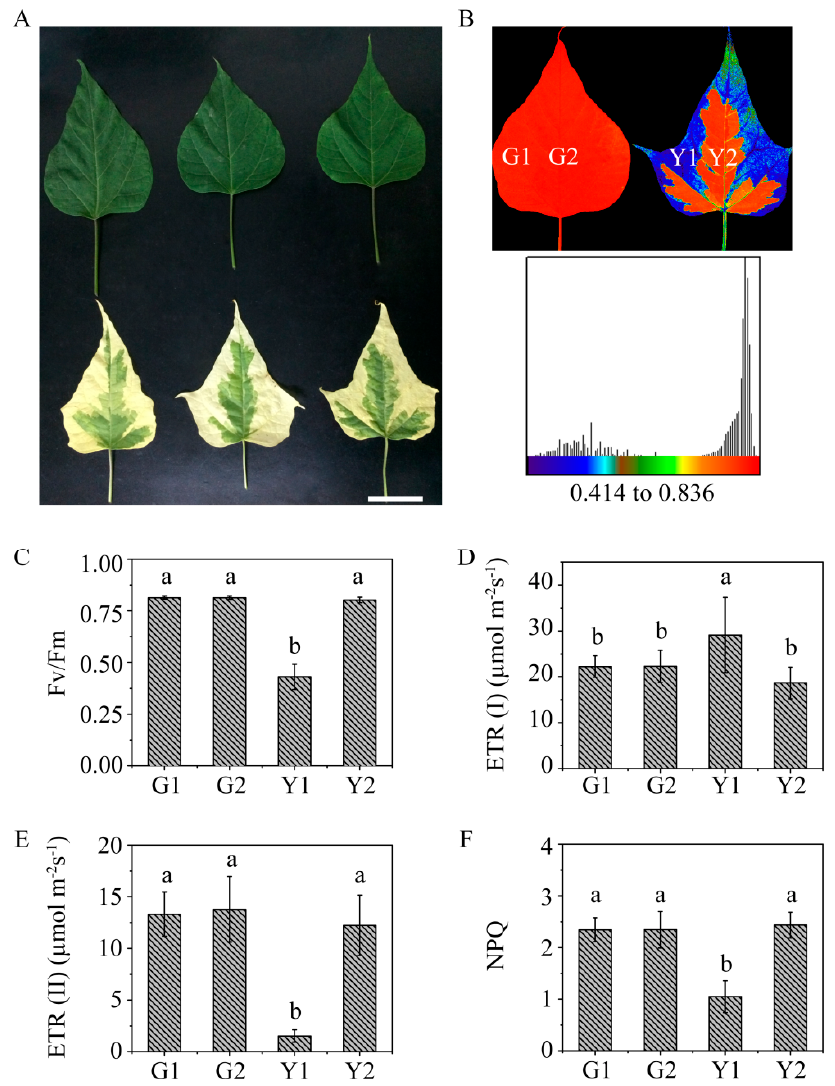
Figure 1. Phenotypic character and determination of photosynthetic fluorescence parameters. ( A ) Leaf phenotypes of C. fargesii (top) and Maiyuanjinqiu (down); the length of white bar represents 5 cm. ( B ) Fluorescence imaging of Fv/Fm; ( C ) The value of Fv/Fm; ( D ) The value of electron transport rate (ETR(I)); ( E ) The value of ETR(II); ( F ) The value of nonphotochemical quenching (NPQ) in G1, G2, Y1, and Y2. The photosynthetically active radiation was 129 µmol·m − 2 ·s − 1 . Bars express the means ± SD ( n = 18), and different letters indicate significant differences ( p < 0.05, one-way ANOVA).